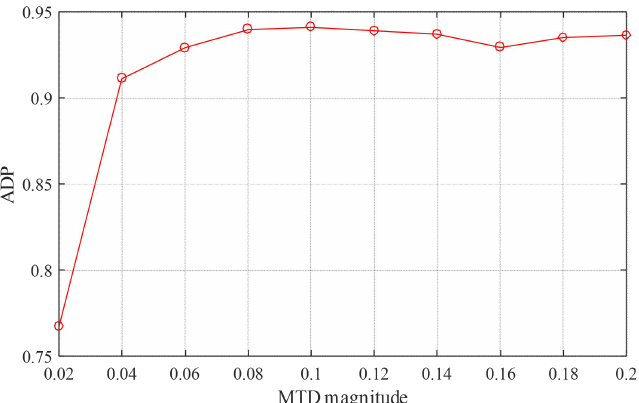
Figure 12. The ADP of RHMTD against the BDD-based alert attacker under different MTD magni- tudes.